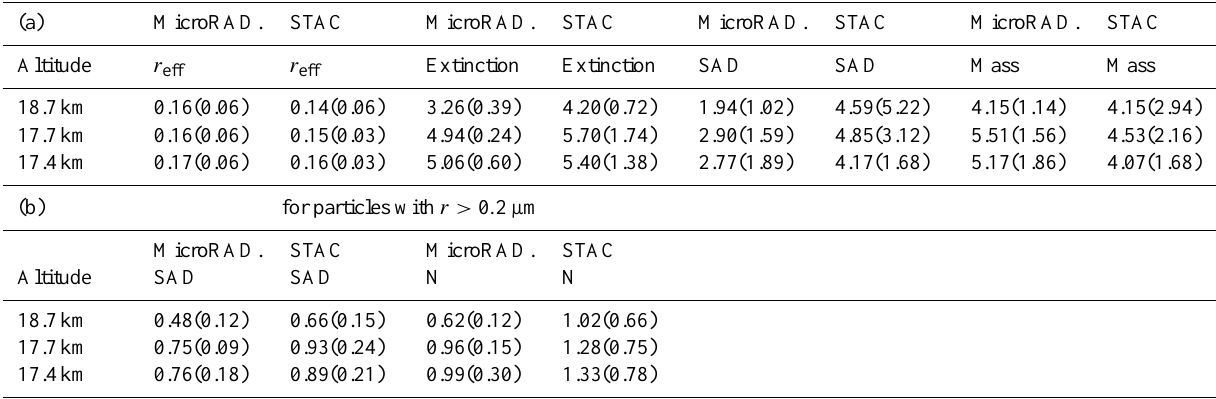
Table 2. (a) STAC (average over ± 250m) and MicroRADIBAL values at 17.4, 17.7, and 18.7km of effective radius (µm), aerosol